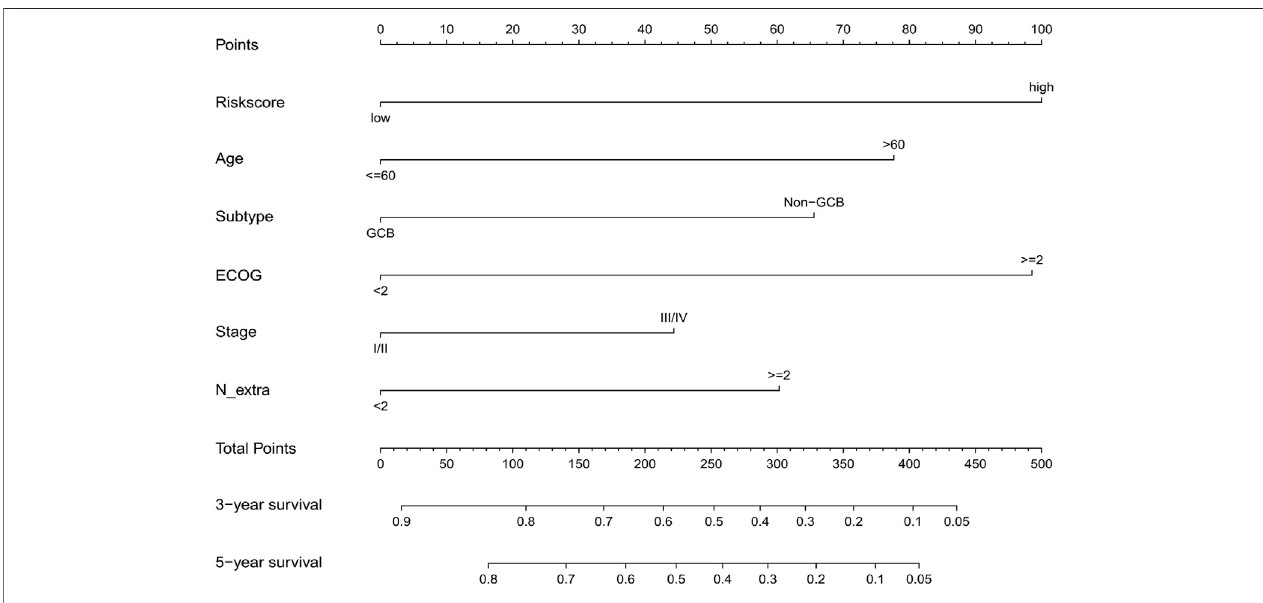
FIGURE 6 | Predictive nomogram was constructed using clinical risk factors and the gene